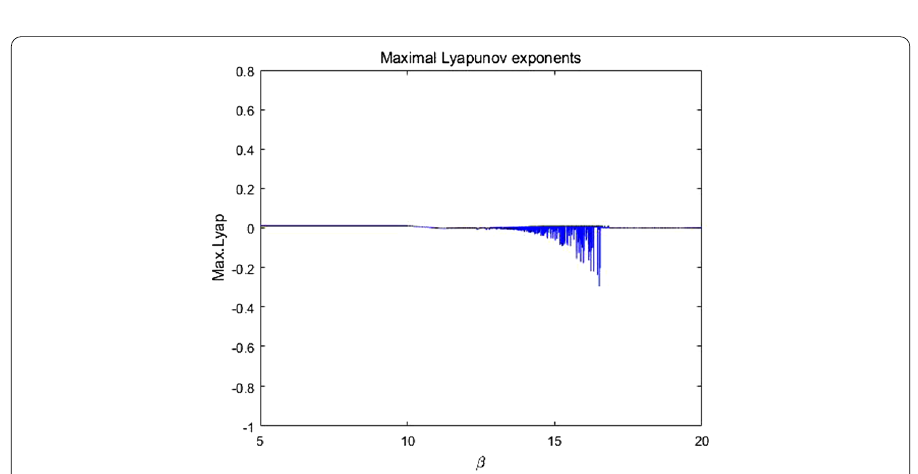
Figure 1 The dynamics of x and y